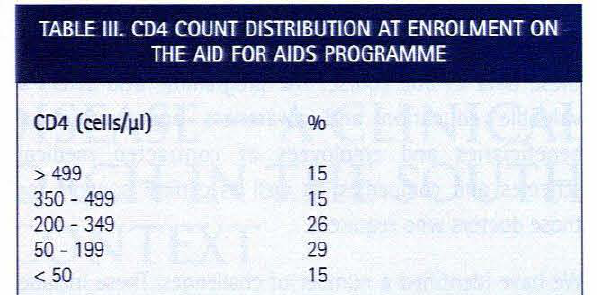
TABLE 11. MKT PCR RESULTS